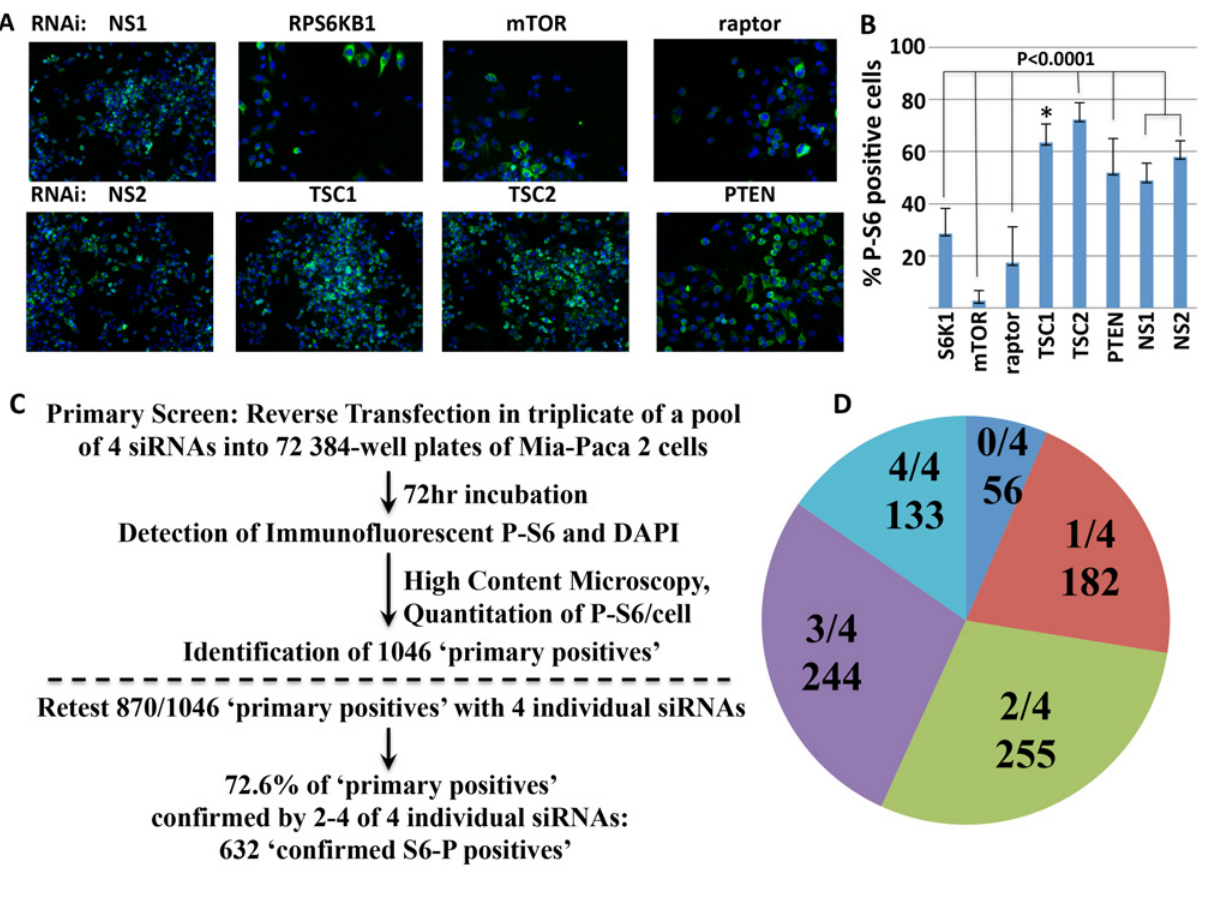
Fig 1. High-throughput image-based screens for genes regulating the phosphorylation of rpS6. A. Immunofluorescence analysis (IF) of rpS6Ser(235/ 236) phosphorylation. Mia-Paca 2 cells were transfected in 384-well plates with a control, nonspecific RNAis NS1 (upper panel) and (NS2) (lower panel), and RNAi pools directed at S6K, TOR and Raptor, TSC1, TSC2 and PTEN. After 72 hours they were fixed, permeabilized and stained by using a rabbit monoclonal anti-S6-P(Ser 235/236) primary antibody, detected with secondary anti-rabbit Alexa 488 antibody (green). Nuclei are stained with DAPI (blue). Representative images are shown. B. Quantitation of cytoplasmic S6-P levels. The bars indicate the % of total MIA PaCa-2 cells (estimated by nuclear count) that exhibit cytoplasmic S6-P immunofluorescence at an intensity above an arbitrary threshold (% S6-P positive cells; see methods). The z ’ is 0.31 for the combined use of NS1 and NS2; because NS2 gave consistently higher z ’ than NS1 (e.g., 0.45 vs 0.32 for the experiment shown) NS2 was used exclusively in the primary screen; error bars represent 1S.D. * = p < 0.01. C. Flow chart of the primary screen: Summary of the screening, hit analysis and hit selection. 21,121 genes were tested using RNAis composed of pools of 4 RNAi oligos (Dharmacon Library); 72 384-well plates were screened in triplicate (See Table 1). The criteria for a “ primary positive ” are described in the text (Table 2 lists genes not scored due to severe inhibition of proliferation). D. Results of the confirmation screen. From the 1046 “ primary positives ” , 870 genes, including all 161 positive kinases and the top 709 ranked by Q (S3 Table), were examined in a confirmation screen wherein each of the four RNAis was tested individually. The pie chart indicates how many of the potential positive hits were confirmed by 0 – 4 individual siRNAs (listed in S4